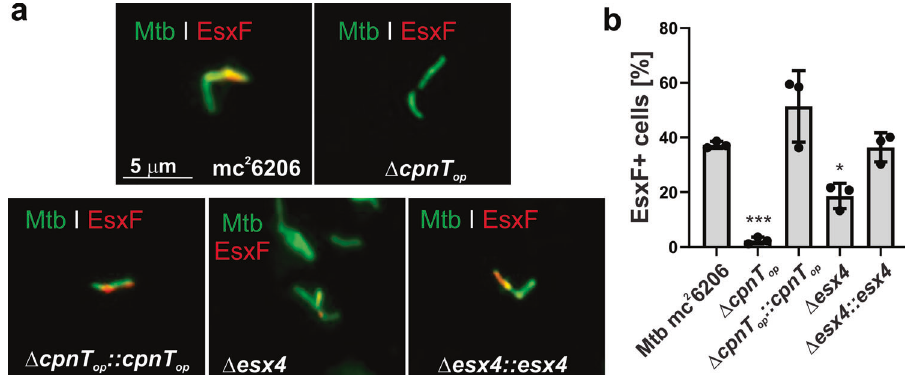
Fig. 3 The ESX-4 system is involved in EsxF export in M. tuberculosis . a Detection of surface-accessible EsxF of the indicated Mtb strains using fl uorescence microscopy. The Mtb strains were labeled with the metabolic dye DMN-trehalose (green), and stained with a polyclonal antibody against EsxF and Alexa Fluor-594 secondary antibody (red). The yellow color indicates co-localization of EsxF with the bacterial cell. b Quanti fi cation of EsxF- positive Mtb cells from images shown in a . Mtb cells were scored as EsxF-positive when a red signal was observed as compared with the Mtb cpnT operon deletion mutant ( Δ cpnT op ). Data are represented as mean ± SEM of three independent experiments ( n = 3) and representative images are shown. Asterisks indicate signi fi cant differences (* p value ≤ 0.05, ** p value ≤ 0.01, *** p value ≤ 0.001, **** p value ≤ 0.0001, calculated using the one-way ANOVA with Dunnett ’ s correction) compared with the Mtb mc 2 6206 strain. Source data are provided in the Source Data fi